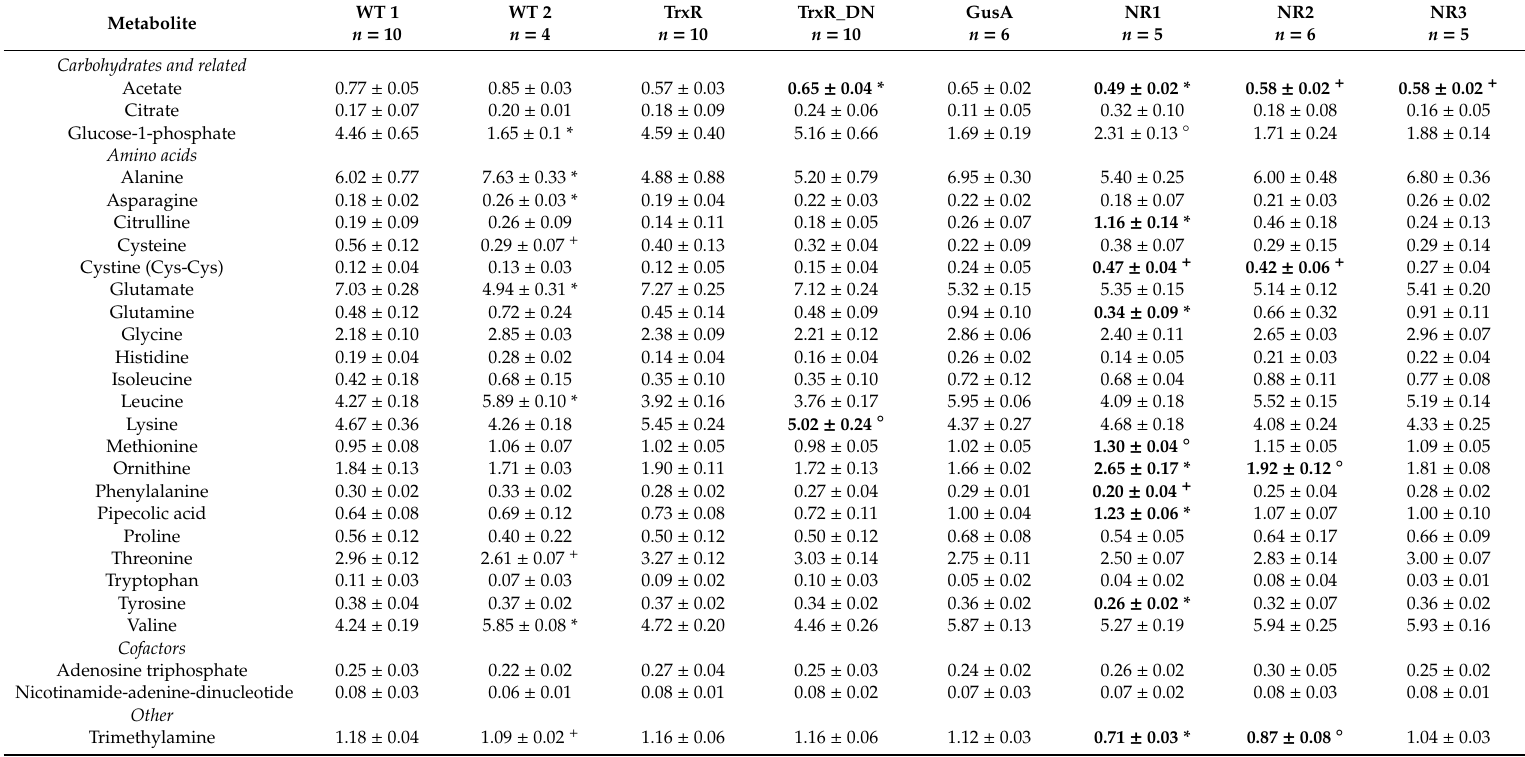
Table 2. Metabolites identified in G. lamblia WBC6 wildtype trophozoites (WT; two independent experiments), in trophozoites overexpressing thioredoxin reductase (TrxR) or a dominant negative mutation of TrxR (TrxR DN) as a control, and in trophozoites overexpressing the nitroreductases NR1, NR2, NR3, or GusA as a control. The values represent normalized integrated peak areas obtained by integration of 1 H-NMR resonances. Values are given as mean values ± SD of arbitrary units for n replicates as indicated. Metabolites with significant di ff erences from the respective controls (i.e., TrxR DN for TrxR and GusA for the NRs) after Bonferroni correction for multiple comparisons are printed in bold (ANOVA followed by t -tests; + , p < 0.05; ◦ , p < 0.01; *, p < 0.001). TMA: